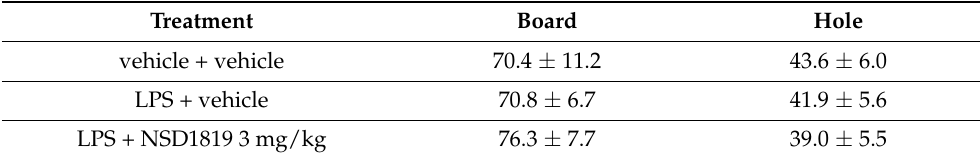
Table 1. Hole board